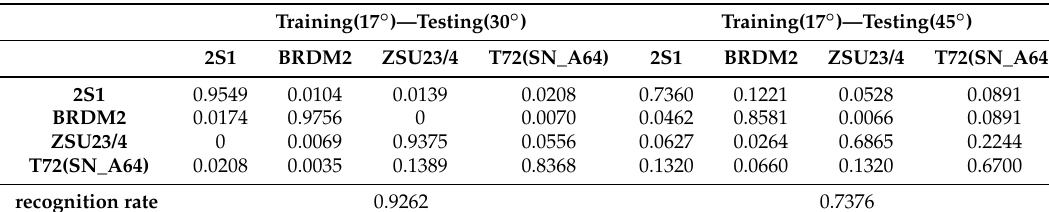
Table 20. The result of LCK-SVD based on SAR-HOG under